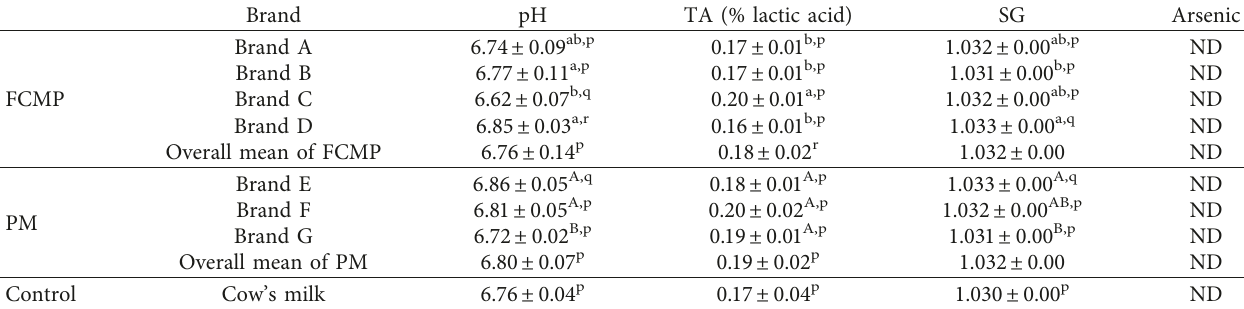
Table 3: Physicochemical properties and arsenic contamination of Sri Lankan-marketed milk.